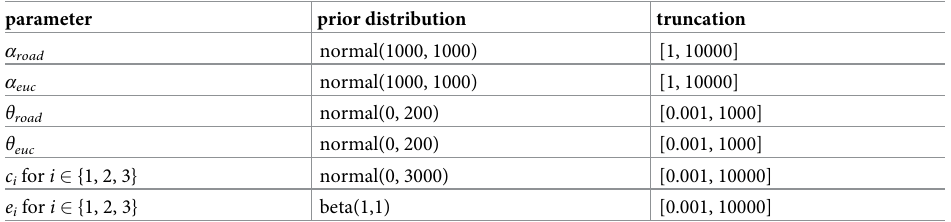
Table 1. The prior distributions used for the parameters of the mechanistic transmission model. The prior distri- butions and their truncation were chosen based on inital model fits. parameter prior